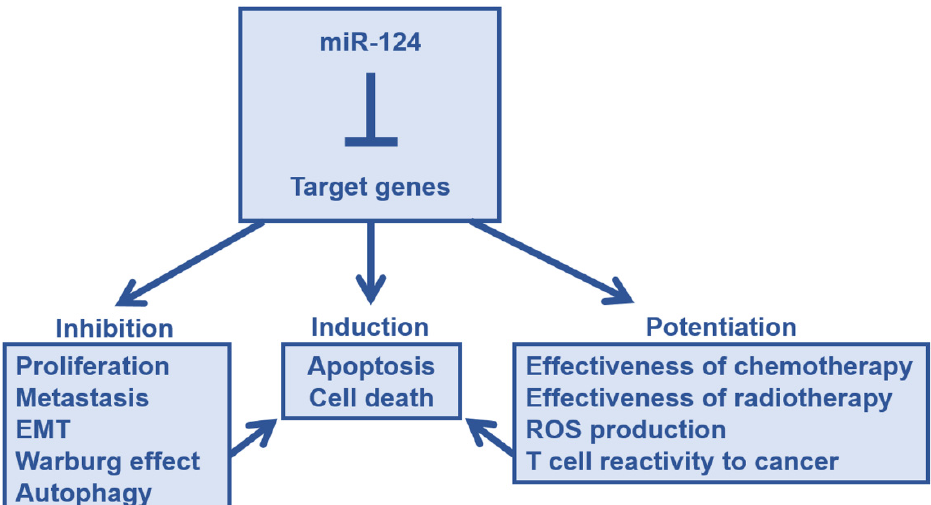
Figure 2. The antitumor effect of microRNA-124. Through the suppression of target gene expression, miR-124 prevents cancer progression and enhances therapeutic effects. These factors collectively lead to direct tumor suppression effects, such as cancer cell death. Abbreviations: ROS, reactive oxygen species; EMT, epithelial-mesenchymal